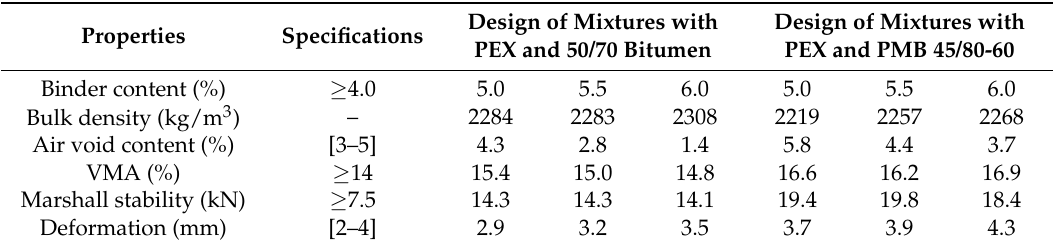
Table 2. Marshall Mix design results obtained for the mixtures incorporating PEX waste, either using